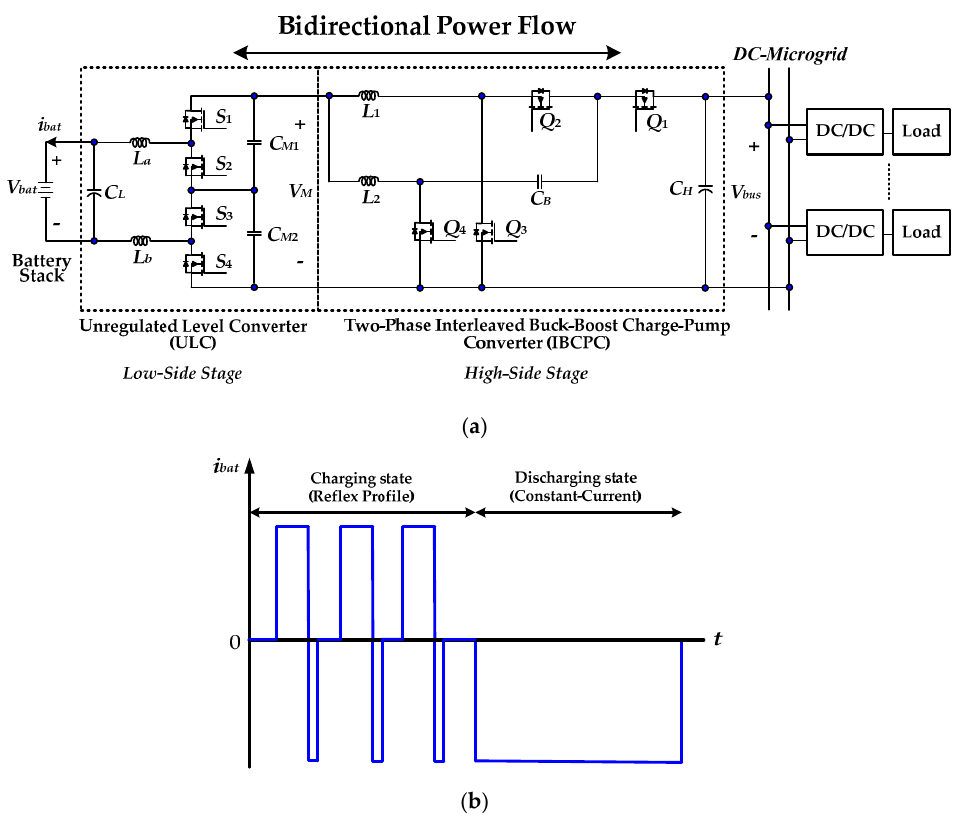
Figure 1. The proposed high-gain reflex-charging-based bidirectional DC charger (RC-BDC): ( a ) circuit topology [20], ( b ) battery current waveforms in charging and discharging states.